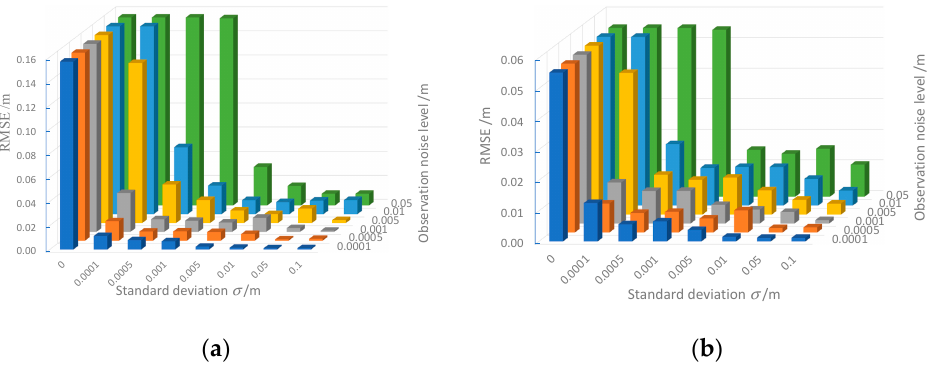
Figure 3. RMSE values with various standard deviation and observation noise level values at ( a ) Station 1 and ( b ) Station 2.